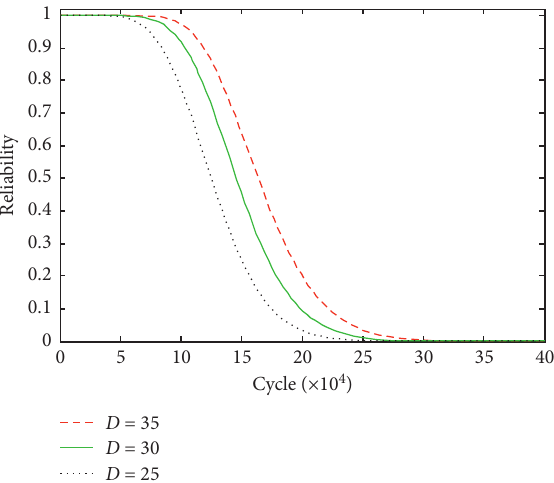
Figure 8: Sensitivity analysis of R ( t ) and on D .